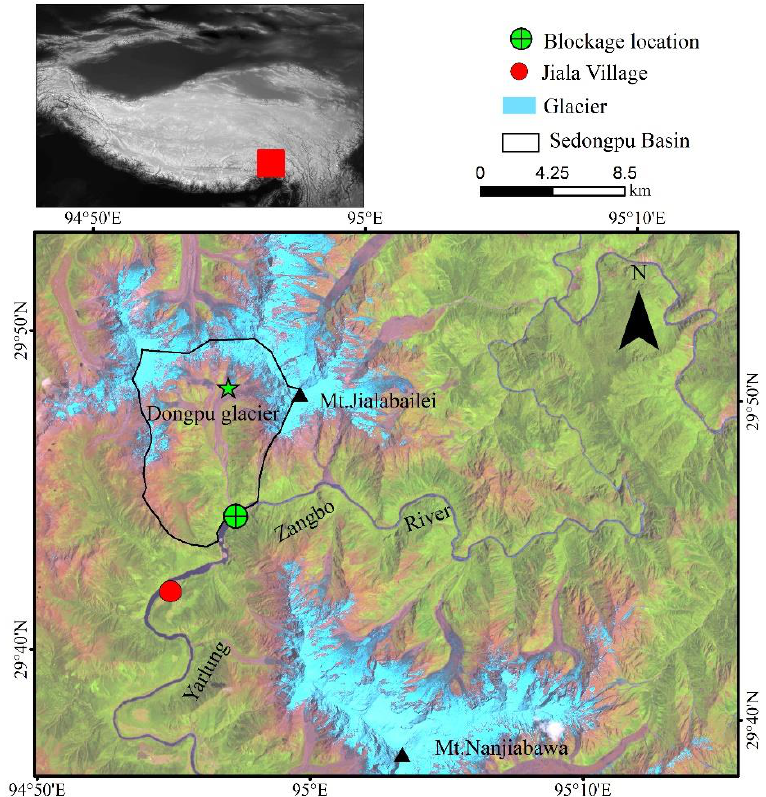
Figure 1. Location of the Sedongpu basin, YZR, the image is Landsat 8 in 2015. Note that the Dongpu glacier is the largest glacier in the Sedongpu basin.